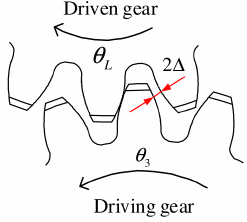
Figure 11. Backlash of